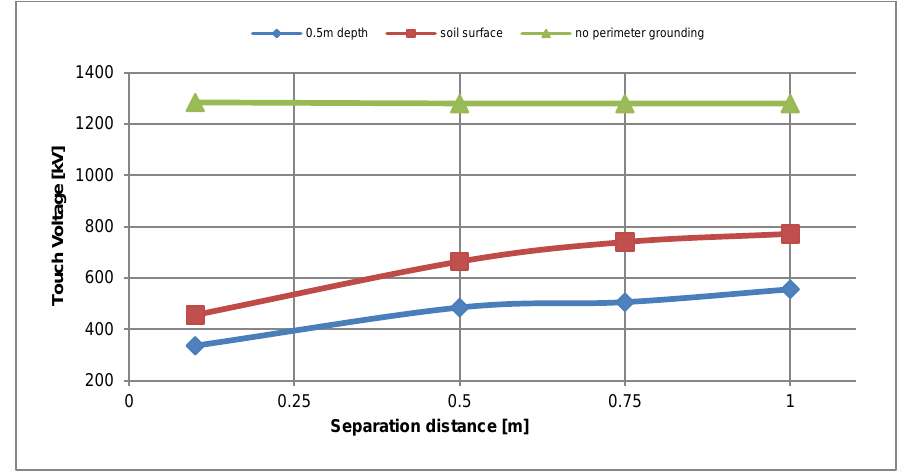
Figure 7. Touch voltages for soil structure D and three examined perimeter grounding cases.